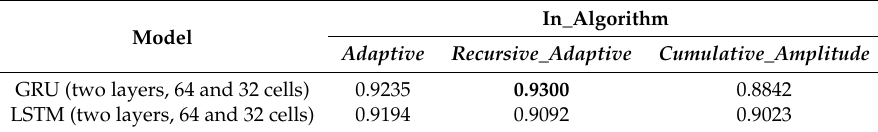
Table 3. Testing accuracy (20% of dataset). Models were run with in _ grid = 32 and look _ back = 256, using four input channels (U RES , U DIFF , I DCCT , I DIDT ), NNs were trained for 7 epochs. The best result is marked in